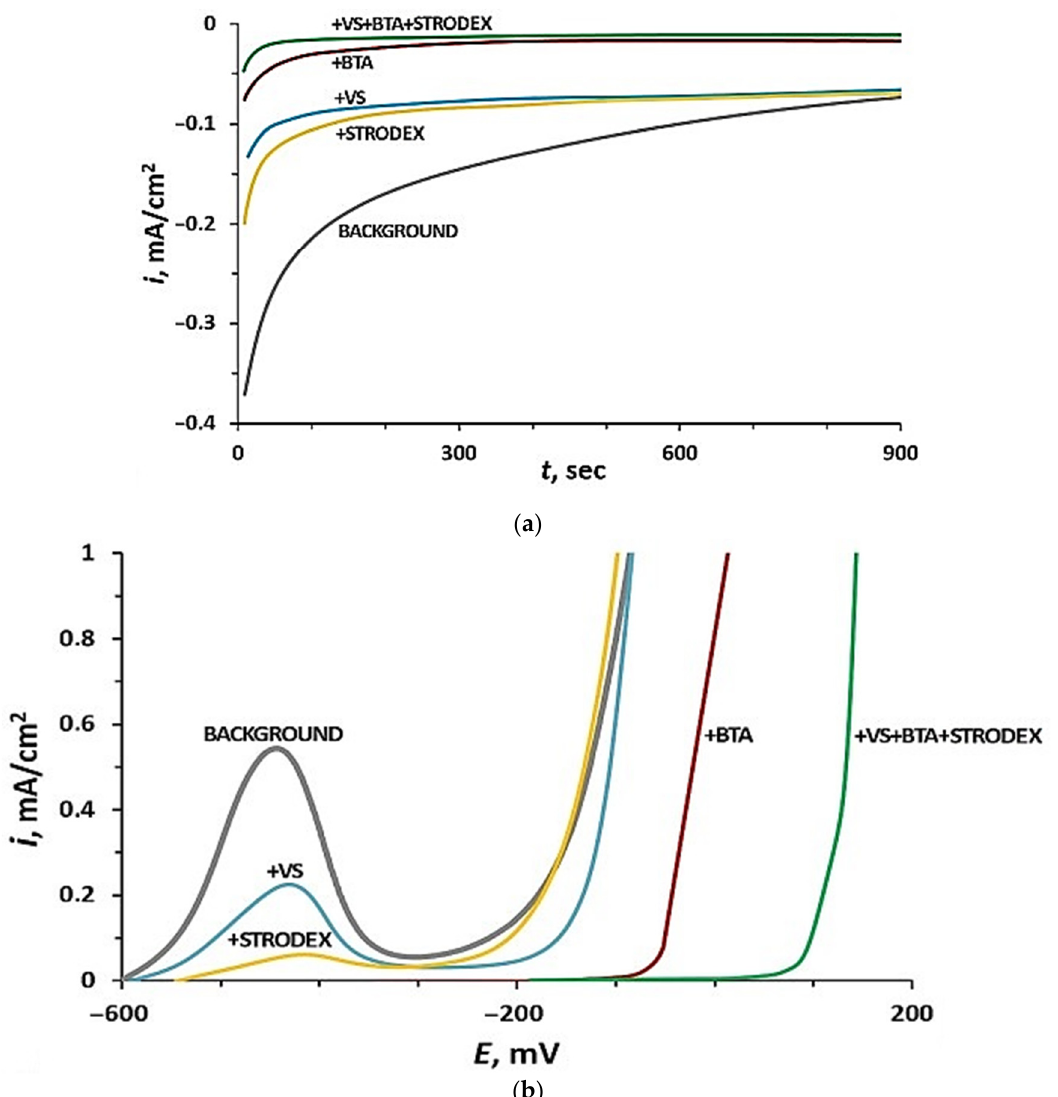
Figure 1. Results of electrochemical studies of St3 in a background solution with the addition of hydrophobic inhibitor dispersions: ( a ) chronoamperograms; ( b ) anodic polarization curves.